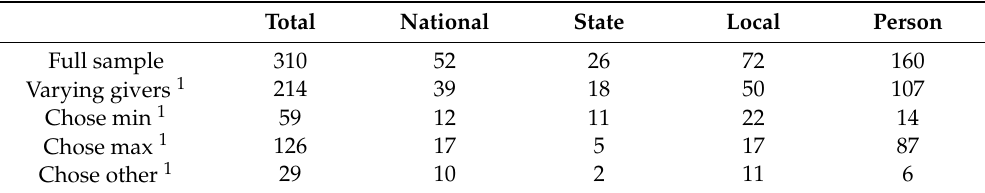
Table 8. Summary of selected dictator game